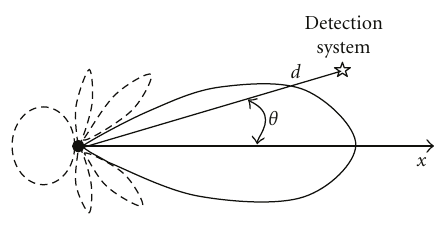
Figure 4: Illustration of d and θ